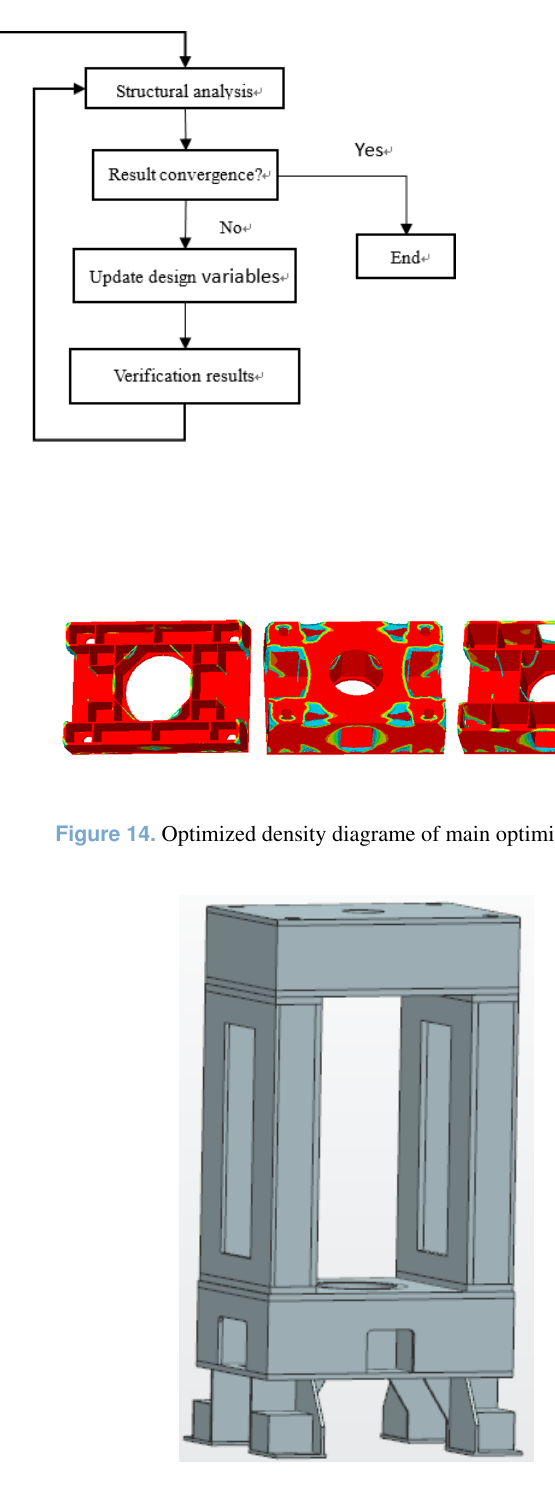
Figure 15. Topology optimizated model of rotary forging frame